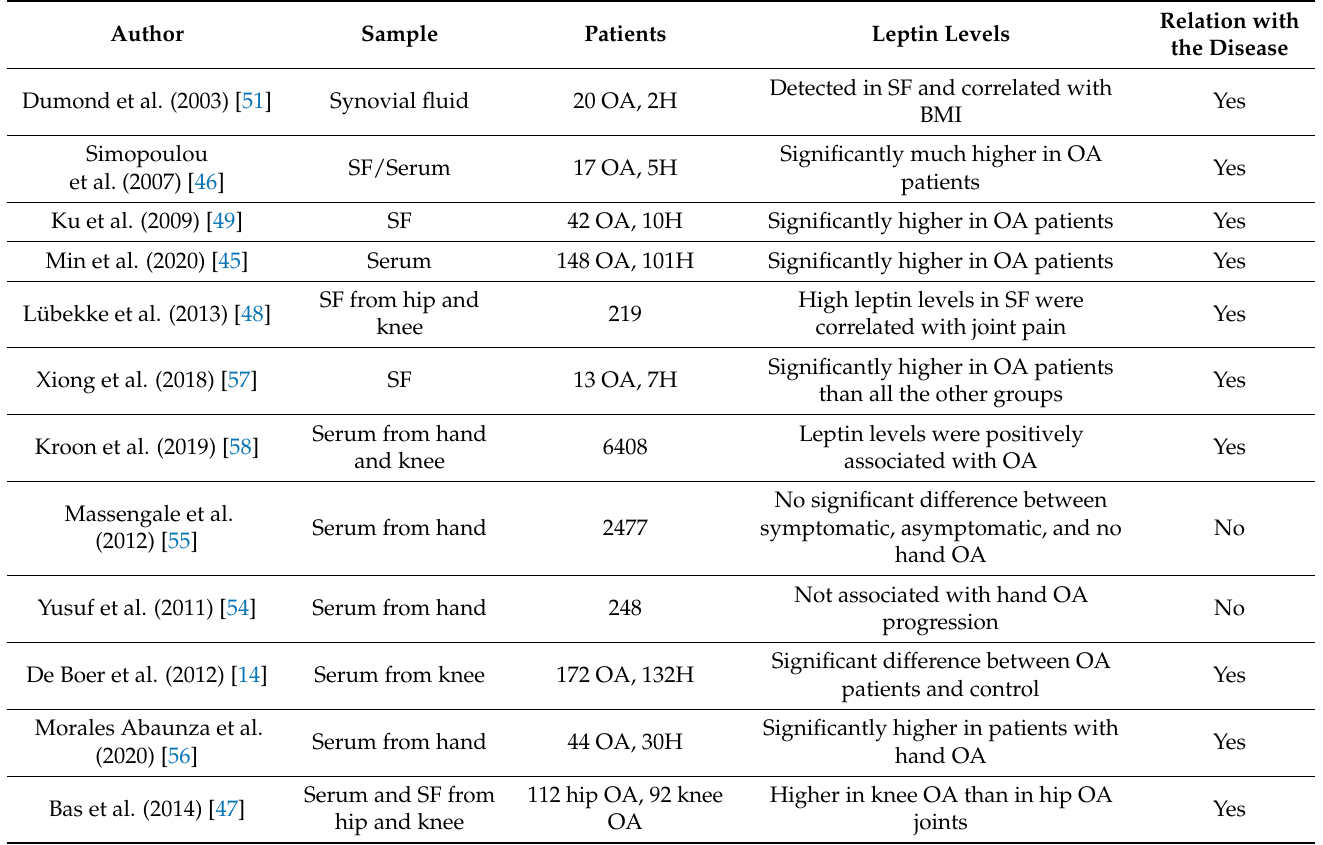
Table 1. Summary of clinical studies on leptin levels in serum and SF of OA